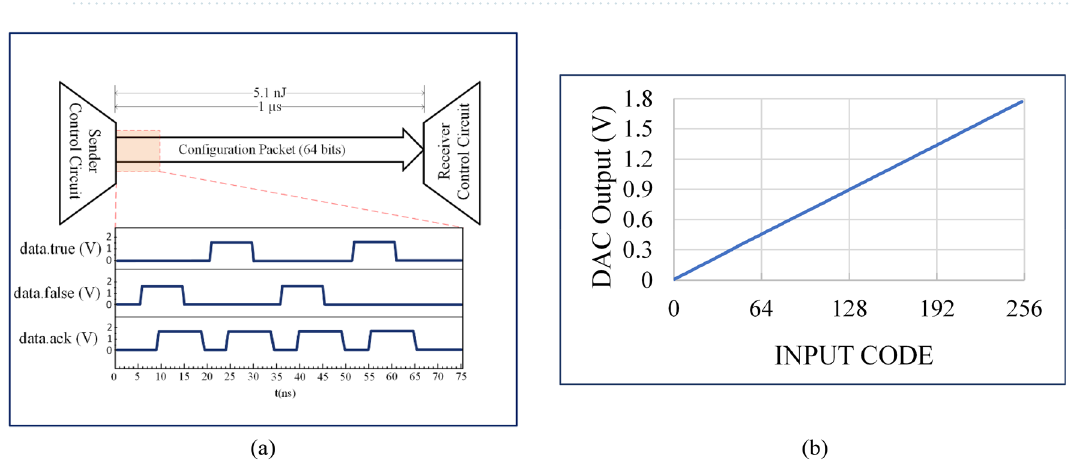
Figure 7. Controller measurements, obtained using an FPGA controlled by a PC, while the test-board was powered using a source-measure-unit (SMU) device. ( a ) Voltage waveforms of the three data signals (data.true, data.false and data.ack) generated by the asynchronous digital control circuit for the binary sequence ‘0101’, together with an illustration of the data flow between neighboring chips in a typical serial communication scheme and ( b ) output voltage of the ‘Digital-to-Analog Converter (DAC) as a function of the input mable metasurface. The size of the test-board is 30 mm × 30 mm as shown in Fig. 6a while the thickness of the test-board is just 3 mm including the chips and the connectors, as shown in Fig. 6b. The chips can be also